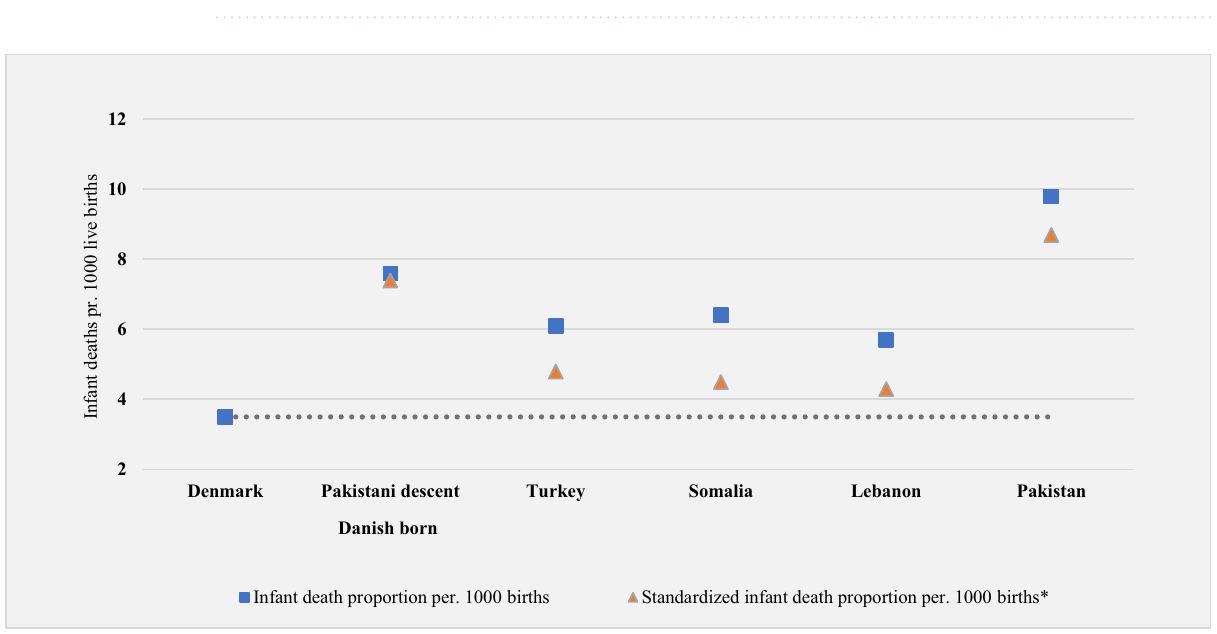
Figure 2. Infant death proportions by maternal country of origin in Denmark 2005–2016 and proportions of infant death standardized by maternal educational level and household